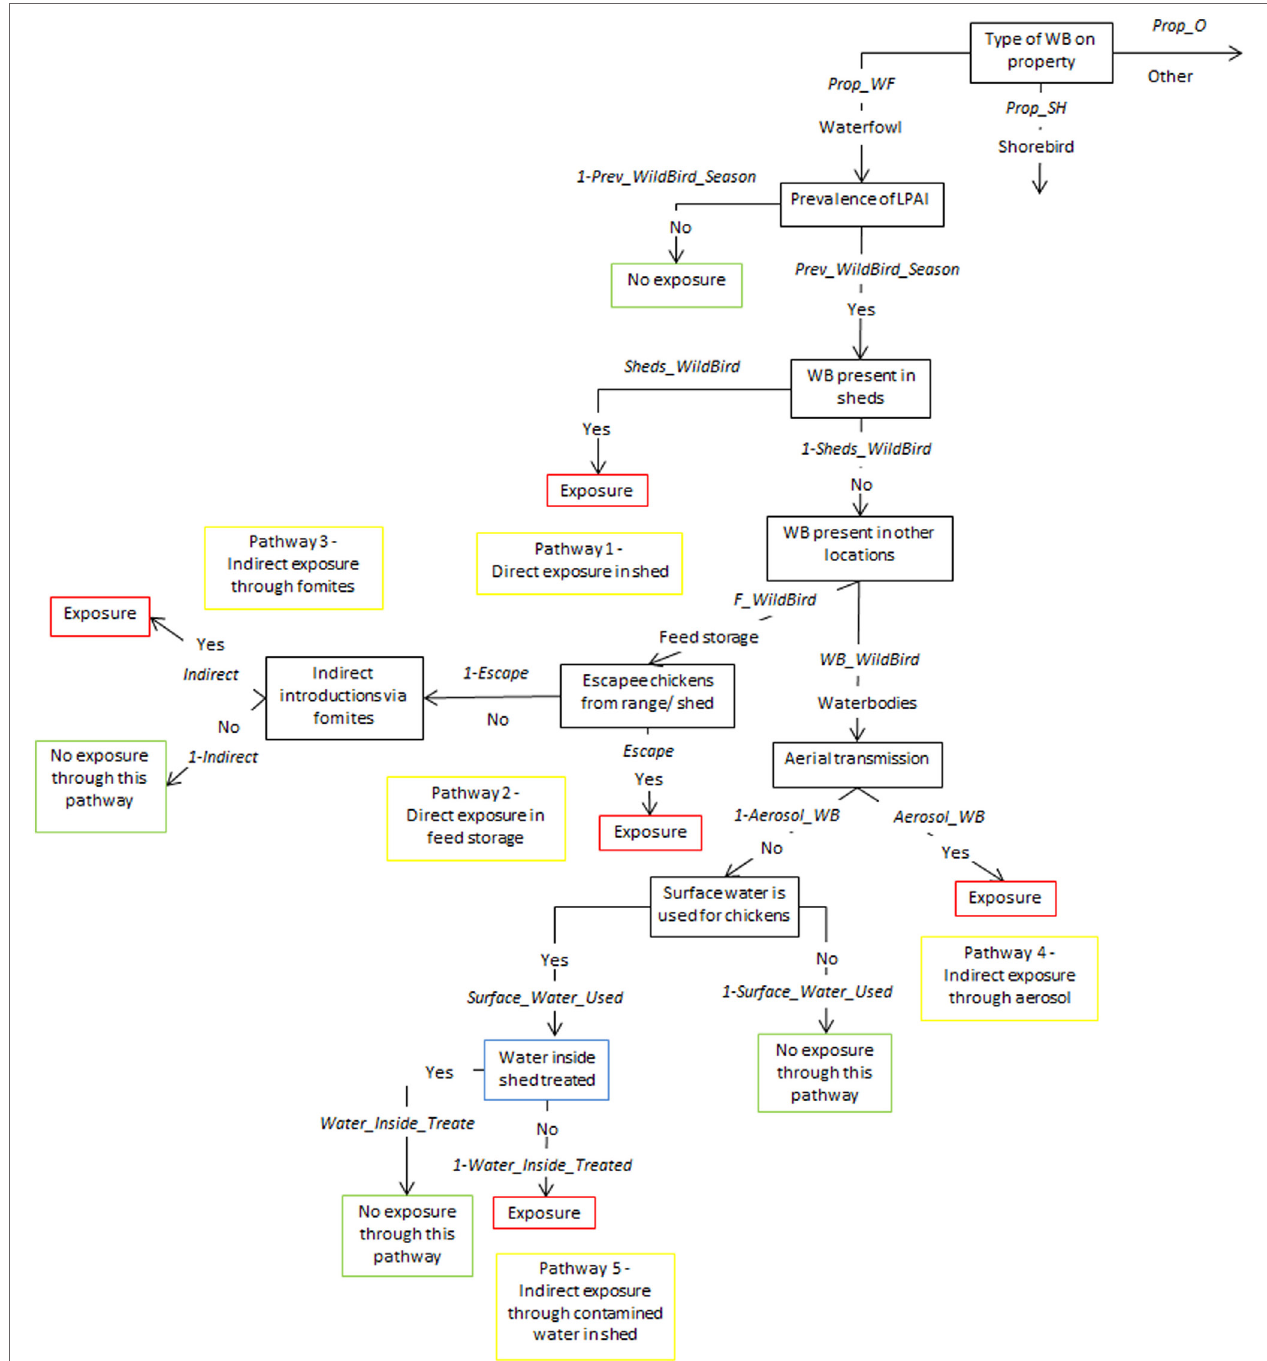
FigUre 2 | Scenario tree representing the exposure of chickens on non-free-range meat chicken farms to low pathogenic avian influenza (LPAI) viruses from wild birds in Australia ( Prop_WF , proportion of waterfowl answers reported on property, Prop_SH , proportion of shorebird answers reported on property, Prop_O , proportion of other bird types reported on property, Prev_WildBird_Season , prevalence of LPAI of the respective wild bird type (waterfowl, shorebird, or other) in the respective season (winter, summer, or autumn/spring), Sheds_WildBird , proportion of farms that reported the respective wild bird type (waterfowl, shorebird, or other) inside chicken sheds on the farm, F_WildBird , proportion of answers that witnessed the respective wild bird type (waterfowl, shorebird, or other) in feed storage areas, WB_WildBird , proportion of answers that witnessed the respective wild bird type (waterfowl, shorebird, or other) in waterbodies on/near the farm, Escape , proportion of farms that reported chickens escaping from shed, Indirect , probability of the occurrence of other indirect methods that can introduce LPAI (boots, mice/rats, insects, farm cats, or dogs), Aerosol_WB , probability of LPAI exposure from aerial dispersion of virus from wild birds on waterbodies, Surface_ Water_Used, proportion of answers that surface water is used for chicken farm, Water_Inside_Treated , proportion of answers that treat water used inside sheds).